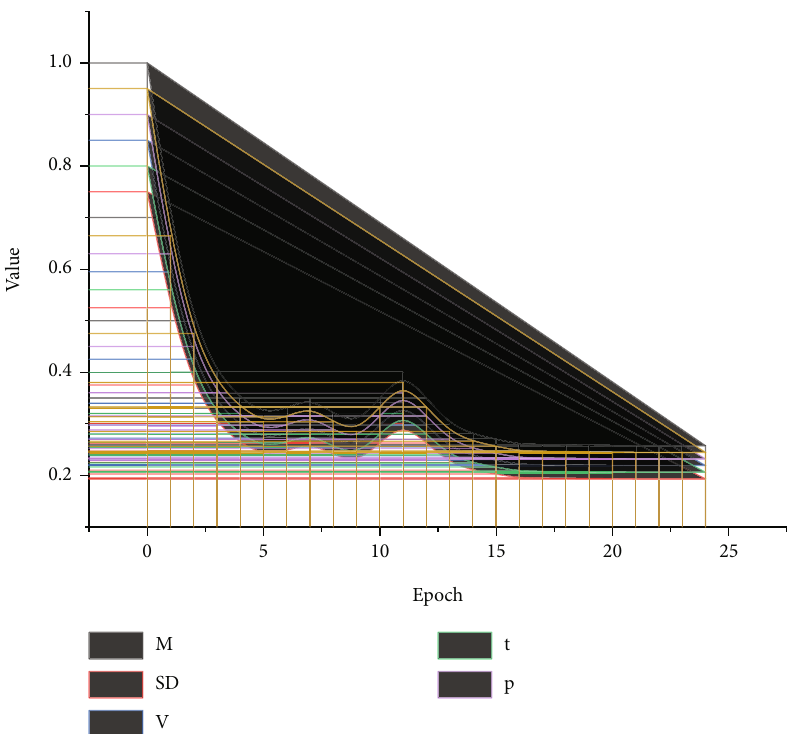
Figure 5: Homogeneity test of positive emotions in two classes.